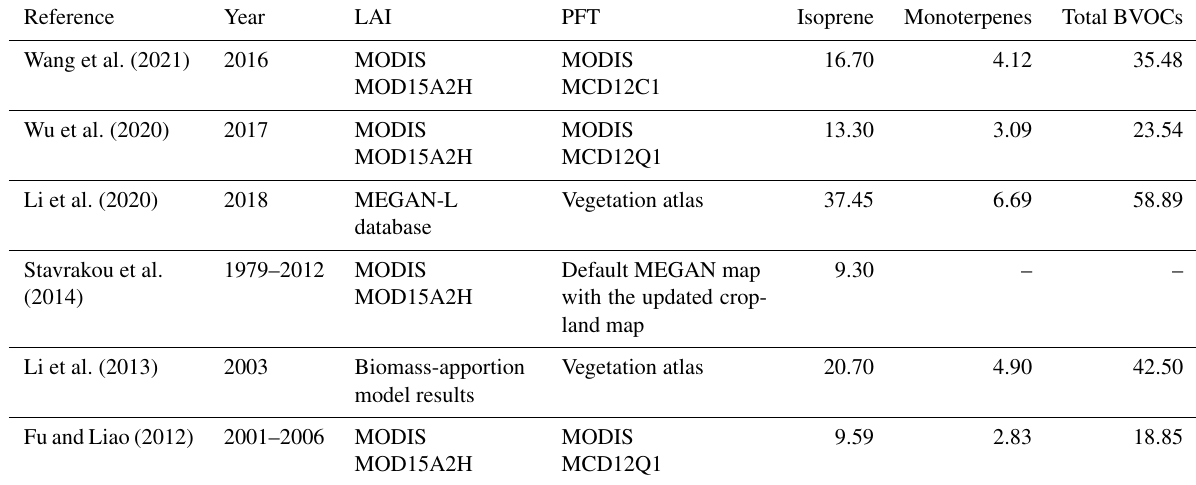
Table 3. Previous studies of BVOC emissions estimated using MEGAN in China; unit is teragrams per year.